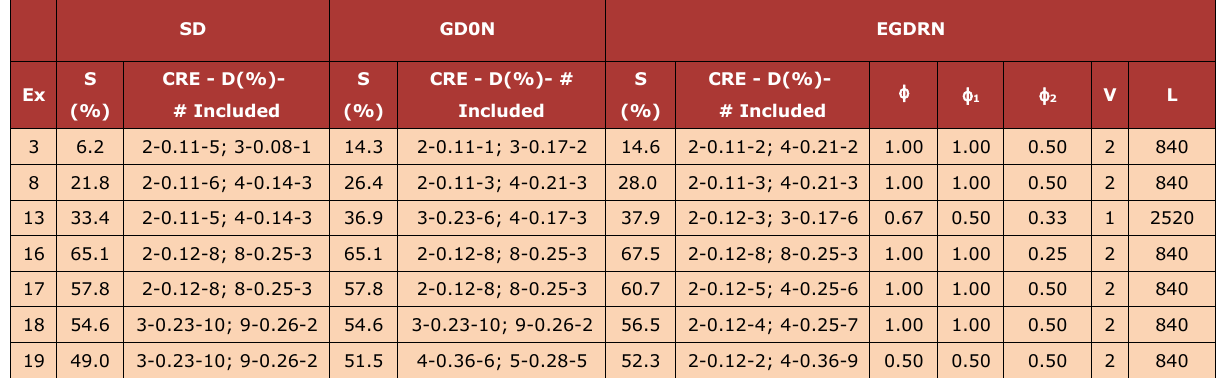
Table 3. Numerical examples with two